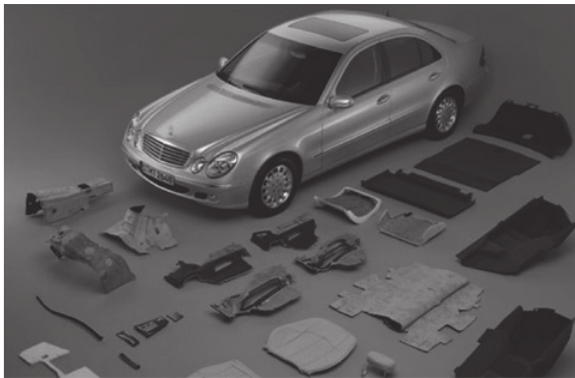
Figure 4: Flax, hemp, sisal, wool and other natural fibers are used to make 50 Mercedes-Benz E-Class components [82]. (© 2006 Springer